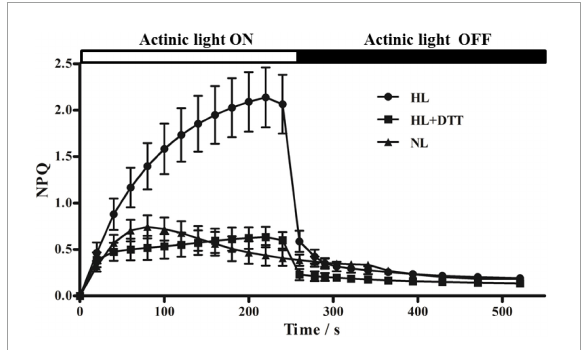
FIGURE1 Non-photochemical quenching (NPQ) kinetics of chlorophyll fluorescence in moso bamboo. Samples were exposed to actinic light at two different intensities (230 µ mol · m − 2 · s − 1 [NL] and 1,075 µ mol · m − 2 · s − 1 [HL]) and then transferred to complete darkness. Additionally, one group of moso bamboo leaves (HL+DTT) was treated with DTT before being exposed to